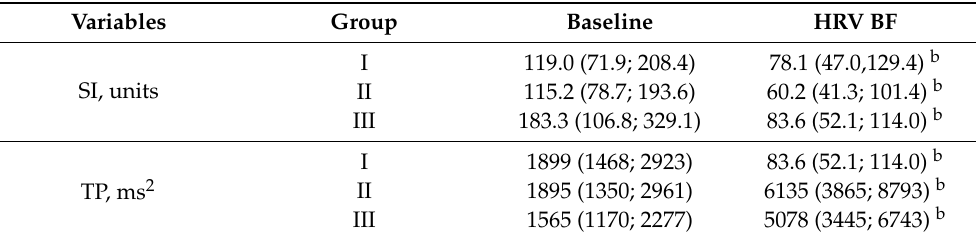
Table 1. Changes in heart rate variability parameters in the dynamics of heart rate variability biofeedback (HRV BF) session in adolescents with different IA risks a . Variables Group